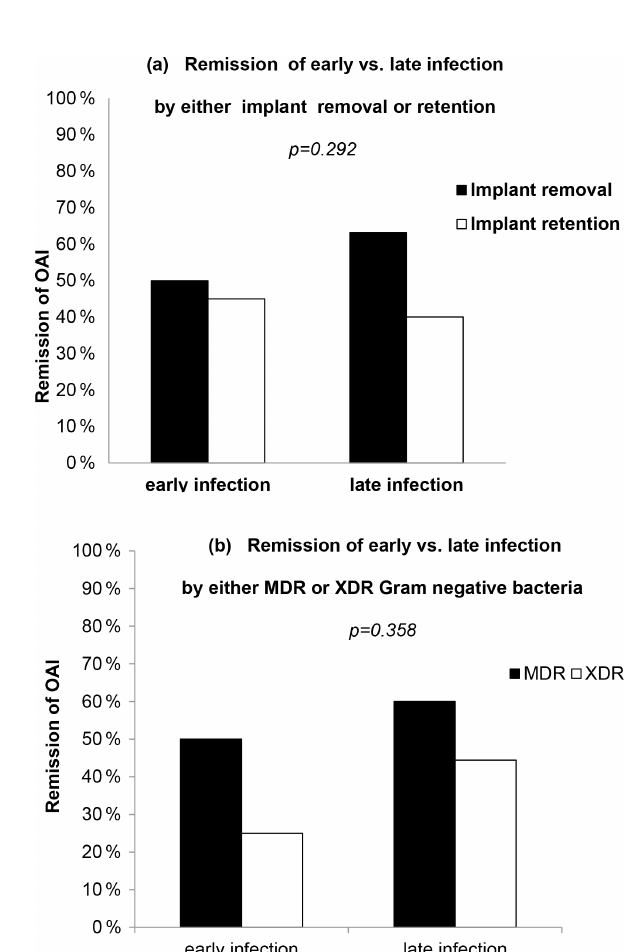
Figure 1. Remission of OAI split by (a) type of surgical treatment or (b) type of antimicrobial resistance.